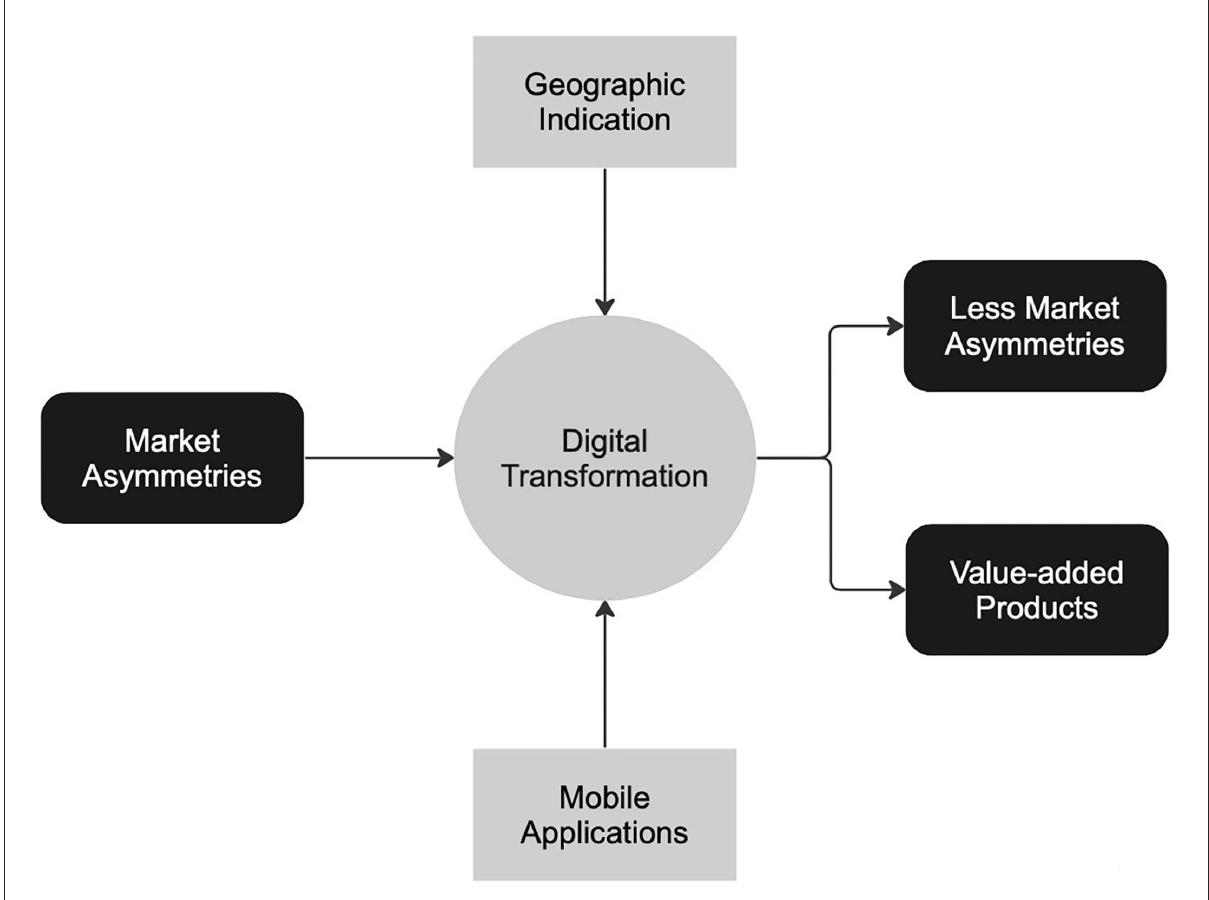
FIGURE1 Flowchart of sections